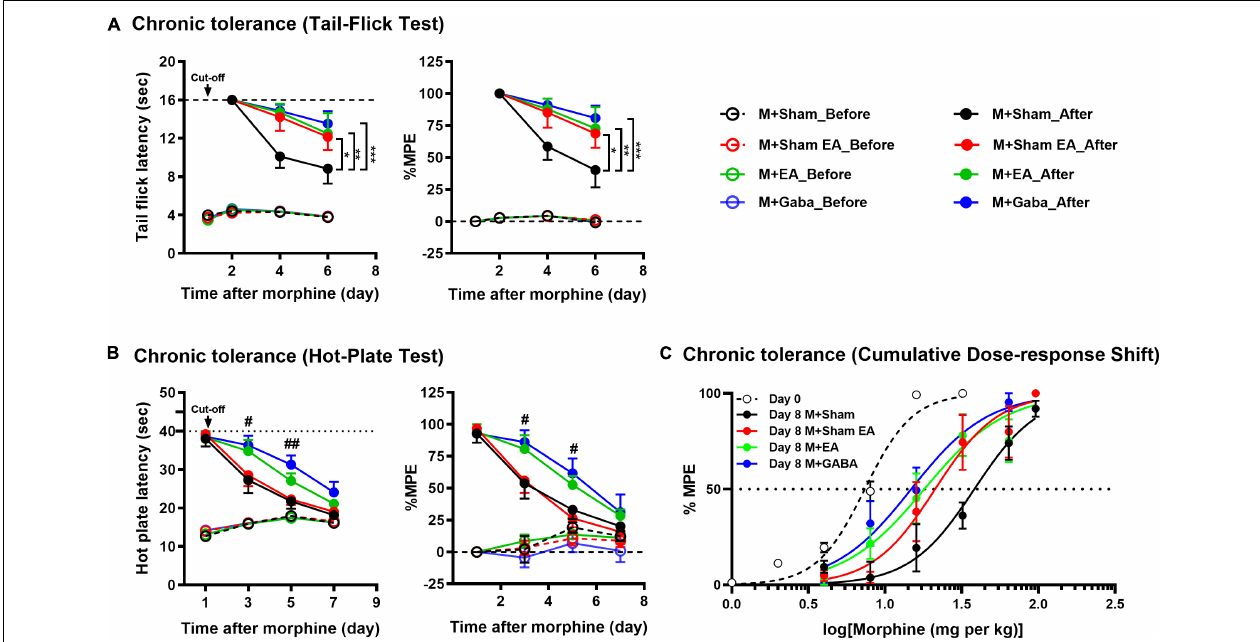
FIGURE 2 | Morphine-induced chronic tolerance evaluated by (A) tail-flick and (B) hot-plate. Mice were treated daily with morphine (10 mg per kg, s.c.); antinociception was assessed 30 min after the injection on the days indicated. Symbols in graphs on left side represent mean ± SEM maximum possible effect (% MPE) or the time of latency. The data were analyzed with two-way ANOVA followed by Bonferroni post hoc tests. F (6,74) = 1.477, F (6,74) = 1.317. ∗ P < 0.05, ∗∗ P < 0.01, and ∗∗∗ P < 0.001 compared to M + Sham_After. In hot-plate, day 3: left, F (3,26) = 3.369; right, F (3,26) = 5.410. day 5: left, F (3,25) = 3.538; right, F (3,25) = 7.188. # P < 0.05, ## P < 0.01, M + GABA_After vs. M + Sham_After. (C) Dose-response curves were determined by tail-flick assay using a cumulative dosing scheme on day 0 to day 8. On day 1, mice were treated with 1, 2, 4, 8, and 16 mg per kg morphine (s.c.). On day 8, mice were again challenged with 4, 8, 16, 32, 64, and 96 mg per kg morphine (s.c.). ED50 (50% effective dose) values were calculated by non-linear regression analysis (GraphPad Prism). Each point in graphs represents mean ± SEM maximum possible effect (% MPE). Dotted lines indicate 50% MPE; 95% confidence intervals: day 0: 7.368 (6.859 to 7.894); day 8: M + Sham, 38.17 (30.41 to 47.10); M + Sham EA, 21.18 (15.94 to 28.44); M + EA, 18.00 (13.37 to 24.12); M + Gaba, 14.79 (11.36 to 19.13).